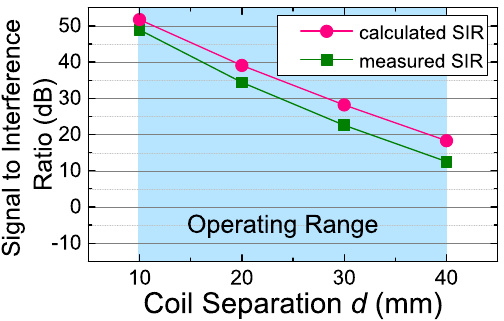
Figure 13. Measured and calculated uplink SIR at the output of the uplink filter versus the coil separation d